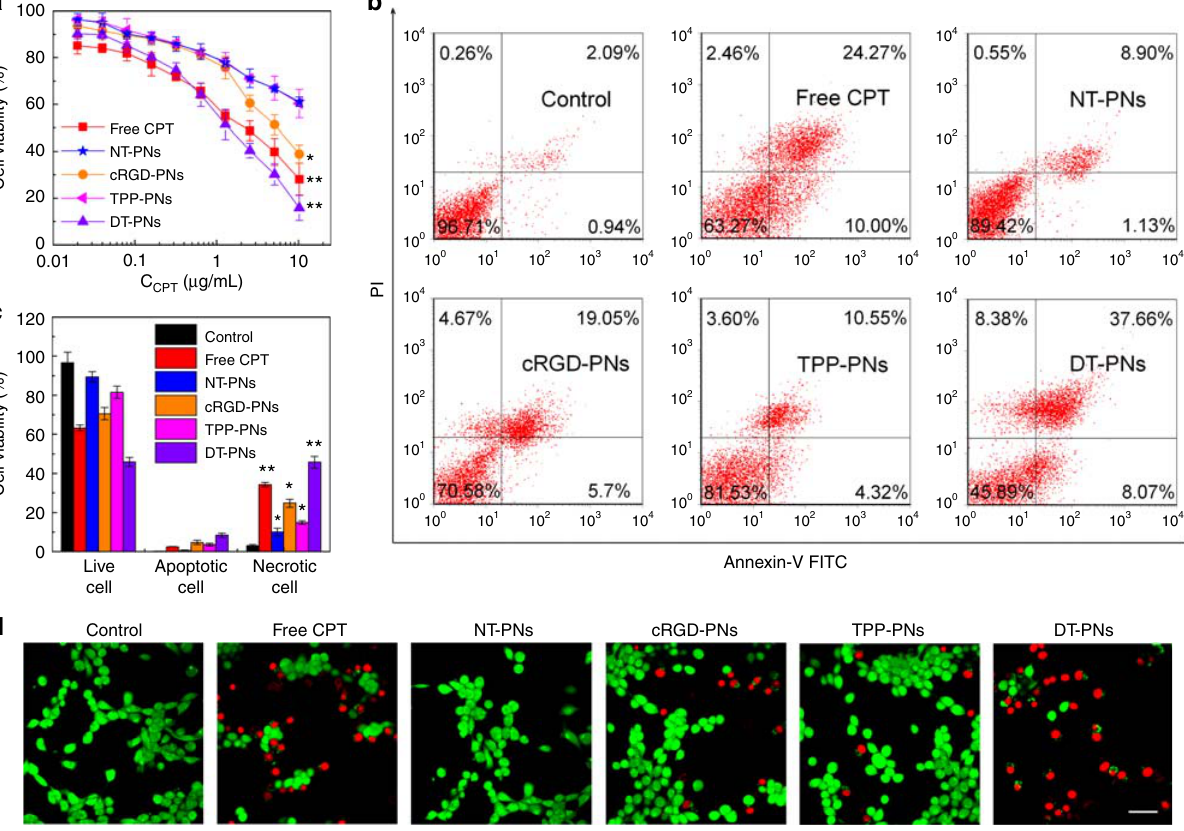
Fig. 7 In vitro cytotoxicity and the analysis of apoptosis/necrosis. a In vitro cytotoxicity determined by MTT assay against 4T1 cells upon 36 h treatment with fi ve different samples. The mean value was calculated by the t test (mean ± s.e.m. n = 6). * p < 0.05, ** p < 0.01, compared with the NT-PNs group. b Cell apoptosis and necrosis analyzed by fl ow cytometer with Annexin V-FITC/PI double staining after different treatments. c Statistical analysis for the percentage of apoptotic cells and necrotic cells in b . The mean value was calculated by the t test (mean ± s.e.m. n = 3). * p < 0.05, ** p < 0.01, compared with the control group. d Confocal images of 4T1 cells upon different treatments and stained with Calcein-AM/PI. Live cells were stained green with calcein AM, and dead/later apoptotic cells were stained red with PI (scale bar, 50 μ